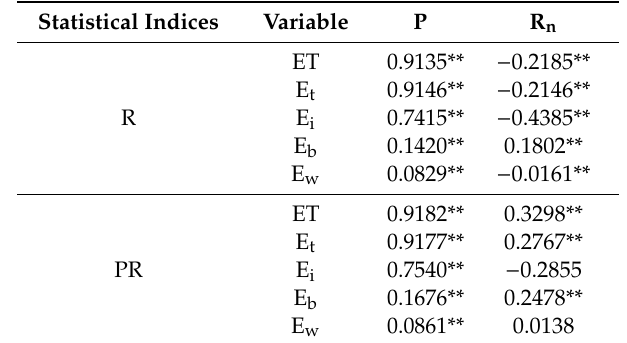
Table 2. Correlation coe ffi cients and partial correlation coe ffi cients between E t (and its components) and P and net radiation (R n ) for